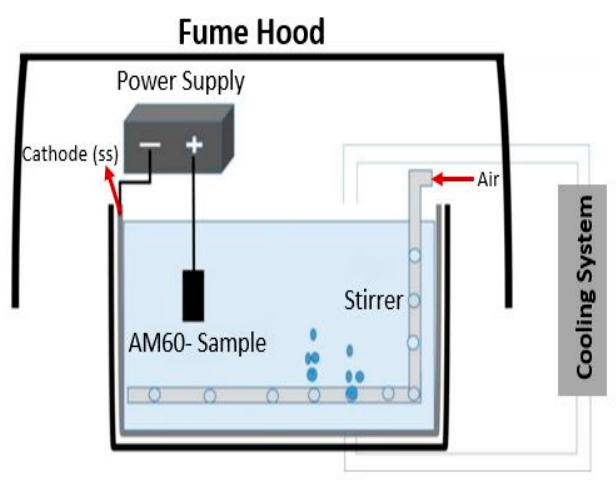
Figure 1. A schematic diagram of the applied PEO process.